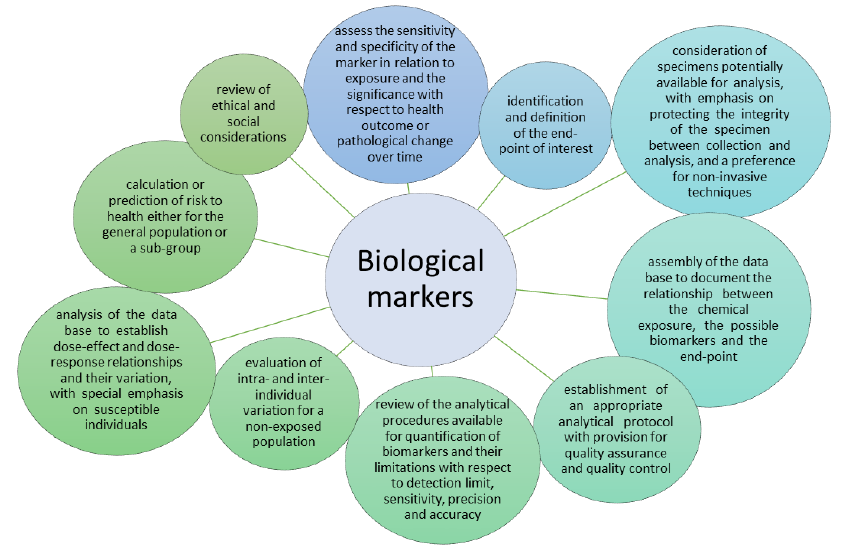
Figure 4. Factors for selecting the most appropriate biological markers according to Lavezzari and Womack [63].